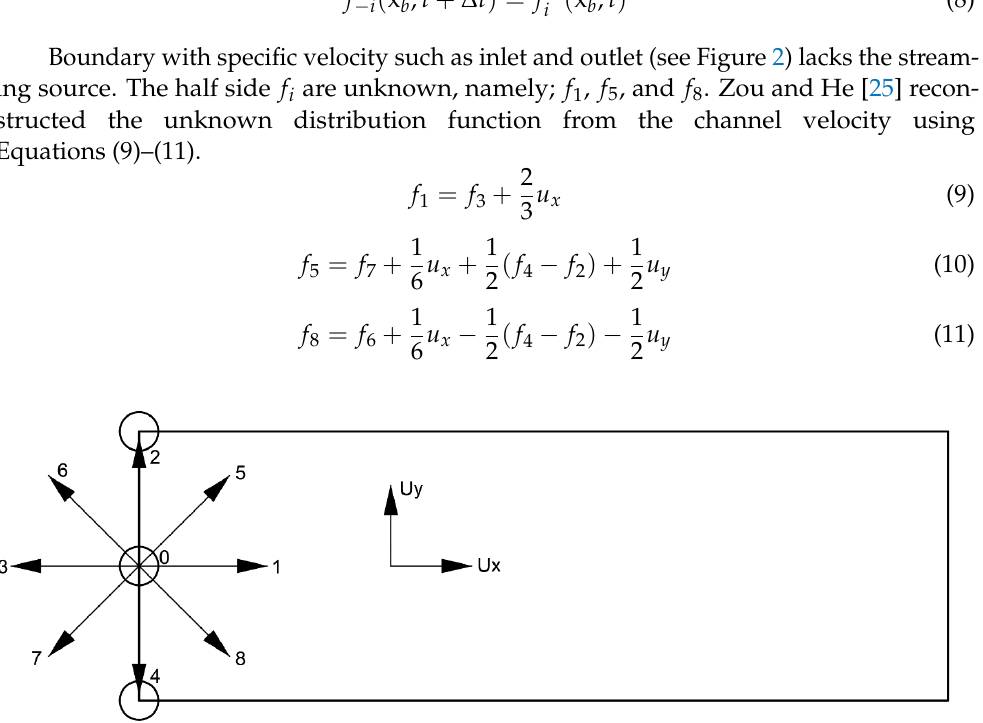
Figure 2. Distribution function of Zou – He boundary. Other boundary condition, such as periodic boundary condition, requires that outlet lattice f i streams to inlet lattice